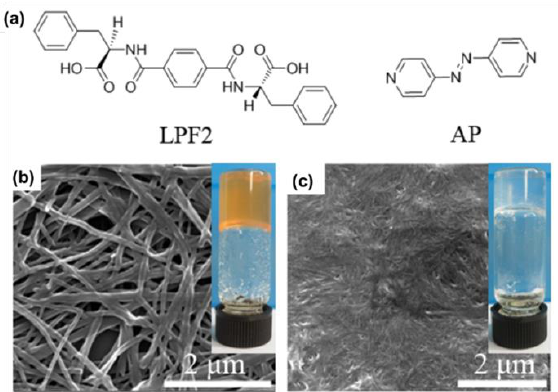
Figure 9. ( a ) Chemical structures of the gelator LPF2 and azobenzene derivative AP; SEM images of ( b ) LPF2-AP gel and ( c ) LPF2 gel. (Inset) Photographs of ( b ) LPF2-AP hydrogel and ( c ) LPF2 hydrogel. Reprinted with permission from [65]. Copyright 2015, American Chemical Society.